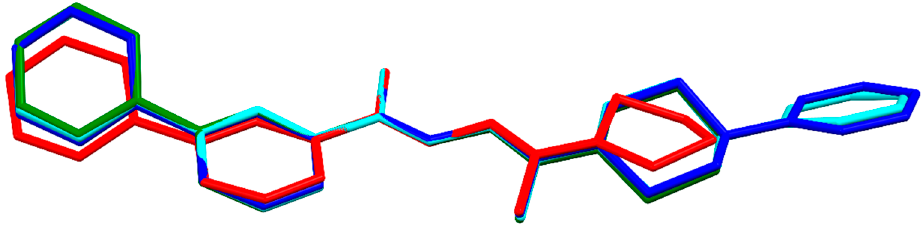
Figure 11. Superimposition of molecules for all determined structures; 1a —red, 1b —green, 1c —blue/turquoise. H atoms were omitted for clarity.